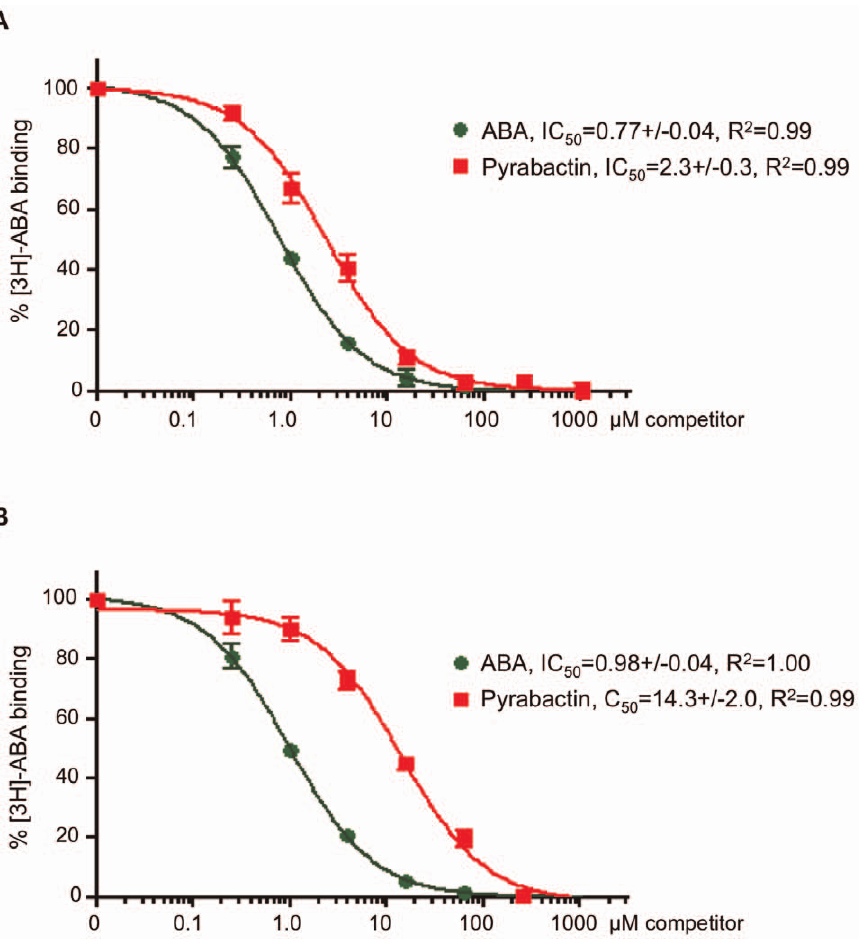
Figure 2. PYL1/PP2C and PYL2/PP2C radioligand competition assays. Competition of the interactions between 3 H-ABA and the PYL1/HAB1 ( A ) and PYL2/HAB1 ( B ) coreceptor complexes by ABA and pyrabactin (n=3, error bars represent s.d.).